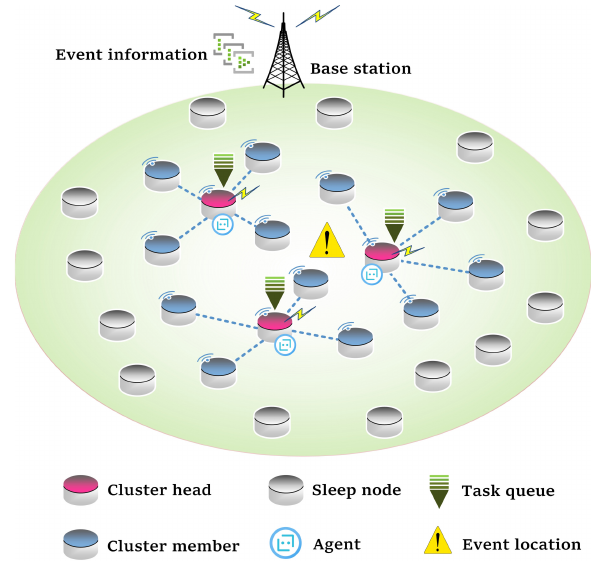
Figure 1. Event-driven WSN